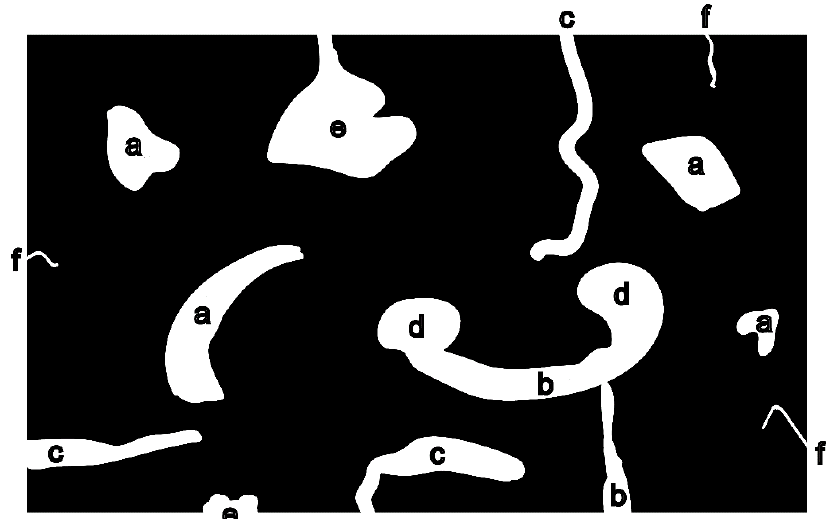
Figure 2. A schematic of various shapes and types of pores frequently identified in ceramics, including ( a ) closed pores ( b ) channel pores ( c ) blind-alley pores ( d ) loop pores ( e ) pocket pores ( f ) micropores. After [40] (p. 350, Figure 12.3).